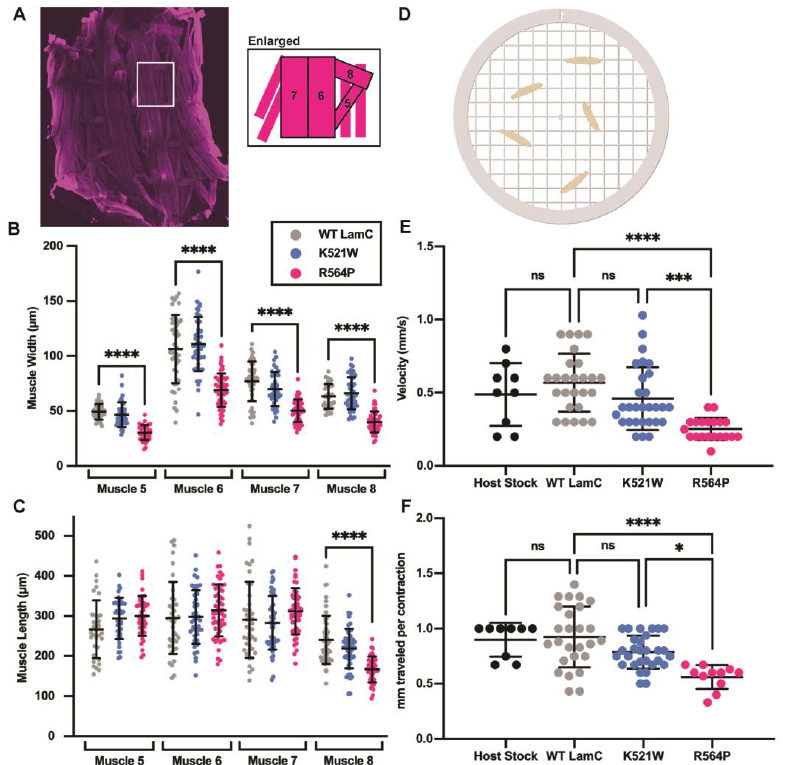
Figure 4. LamC R564P, but not LamC K521W, reduces larval motility and muscle size. ( A ) An image of a muscle filet from a hand-dissected third instar larvae stained with phalloidin (magenta) is shown. The diagram on the right shows the numbered muscles used for measurements. ( B , C ) The width and length of larval body wall muscles were measured for four different muscles diagrammed in A. Values are expressed as mean ± standard deviation with 33–53 muscles from 8–10 larvae analyzed per genotype. Statistical significance was determined using a one-way ANOVA analysis followed by Dunnett’s multiple comparisons test (GraphPad Prism version 9.5.0, GraphPad Software, San Diego, CA, USA) No statistical difference, ns; p > 0.05; * p < 0.05; ** p < 0.01; *** p < 0.001; **** p < 0.0001. ( D ) A diagram of the assay used to measure larval motility (see Materials and Methods for details) (created using BioRender.com; access date 11/2022). ( E , F ) Larval velocity and distance per larval contraction were measured by analyzing two-minute videos of larvae crawling on a thin layer of water in a petri dish. Values are expressed as the mean ± standard deviation, and 9–29 individual larvae were analyzed per genotype. Statistical significance was determined using a one-way ANOVA multiple comparisons analysis followed by Dunnett’s correction (GraphPad Prism version 9.5.0, GraphPad Software, San Diego, CA, USA). No statistical difference, ns; p > 0.05; * p < 0.05; *** p < 0.001; **** p <